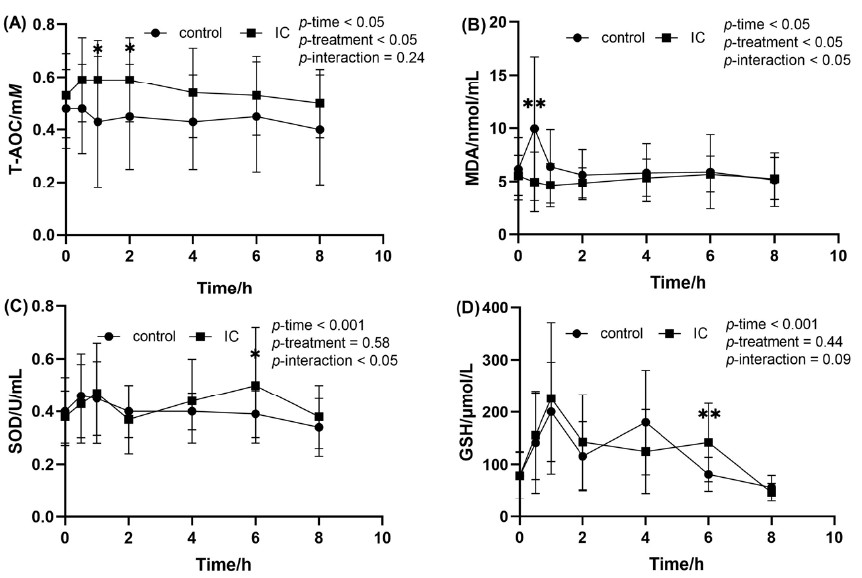
Figure 4. The concentration of MDA, SOD, GSH and T-AOC in the serum sample within 8 h after meal. ( A ) postprandial serum T-AOC concentration; ( B ) postprandial serum MDA concentration; ( C ) postprandial serum SOD concentration; ( D ) postprandial serum GSH concentration. Data are expressed as mean ± SD (n = 18), with *: p < 0.05, **: p < 0.01.